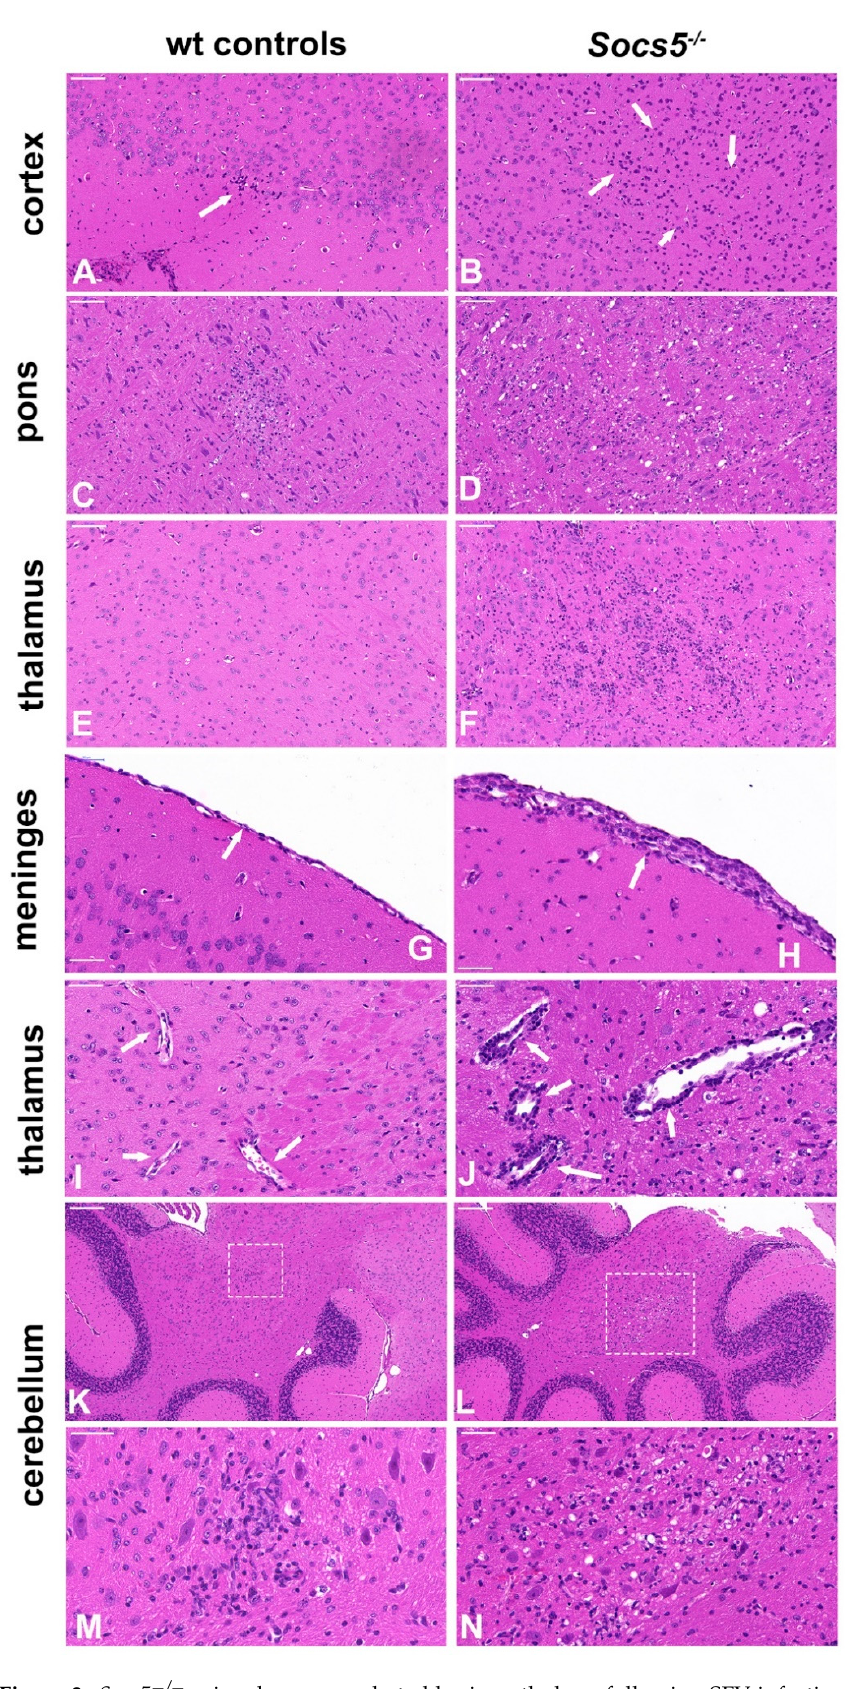
Figure 3. Socs5 − / − mice show exacerbated brain pathology following SFV infection. Brains from Socs5 − / − mice and control mice were removed ( n = 2 for each genotype) on 8 dpi, sectioned